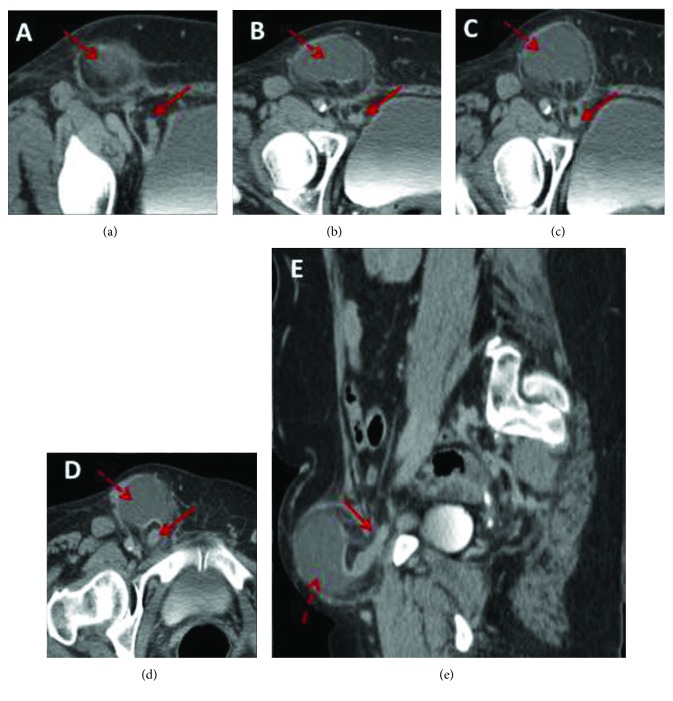
Axial contrast-enhanced CT images (a–d) demonstrate the appendix (solid arrows) entering into the right femoral hernia sac in keeping with a de Grangeot hernia. Within the hernia sac there is a fluid collection (dashed arrows) concerning for abscess or mucocele. Findings are confirmed on the sagittal reformatted image (e).